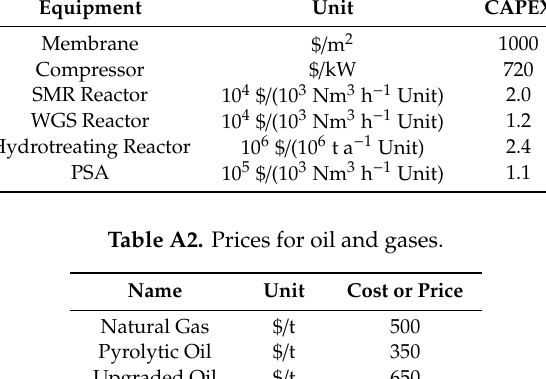
Figure S1: Liquid special hourly velocity of pyrolytic oil hydroprocessing reactor. Figure S2: Impacts of membrane area (Membrane-203) on conversion and hydrogen consumption. Table S1: Mass balance of SMR-HT process. The reactor sizing and impacts of the membrane area of Membrane-203 were provided in the supplementary file.